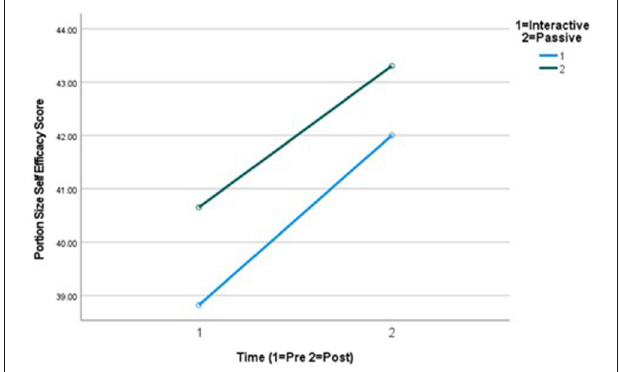
FIGURE 5 | Plot diagram of portion size self